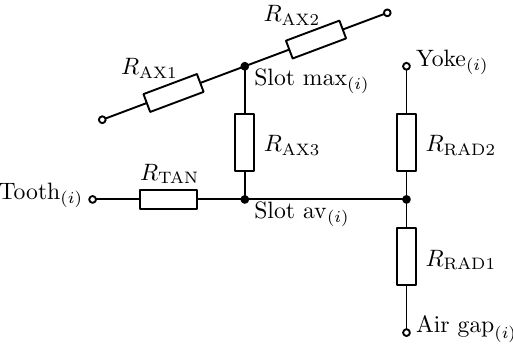
Figure 5. Slot thermal